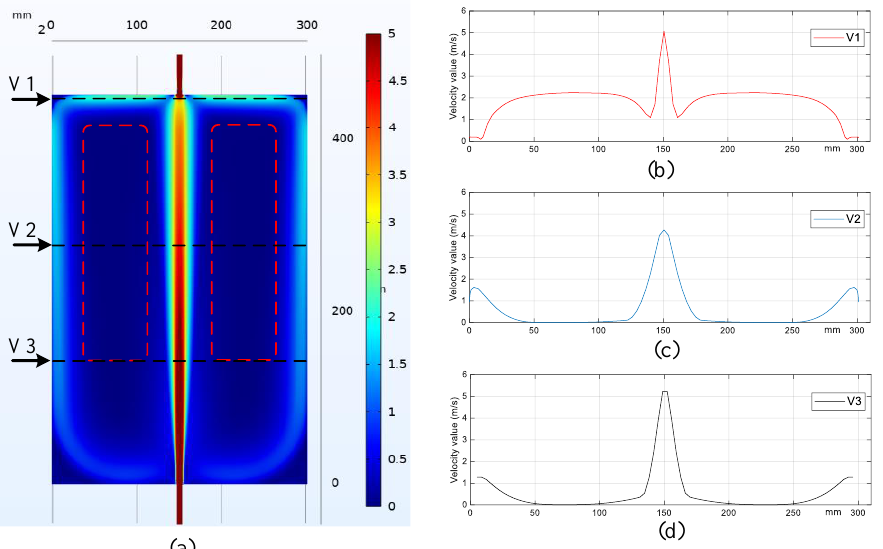
Figure 15. Simulation results of the PFHE: velocity field ( a ) and velocity values of the horizontal lines with a distance of 150 mm ( b ), 300 mm ( c ), and 400 mm ( d ) from the inlet.